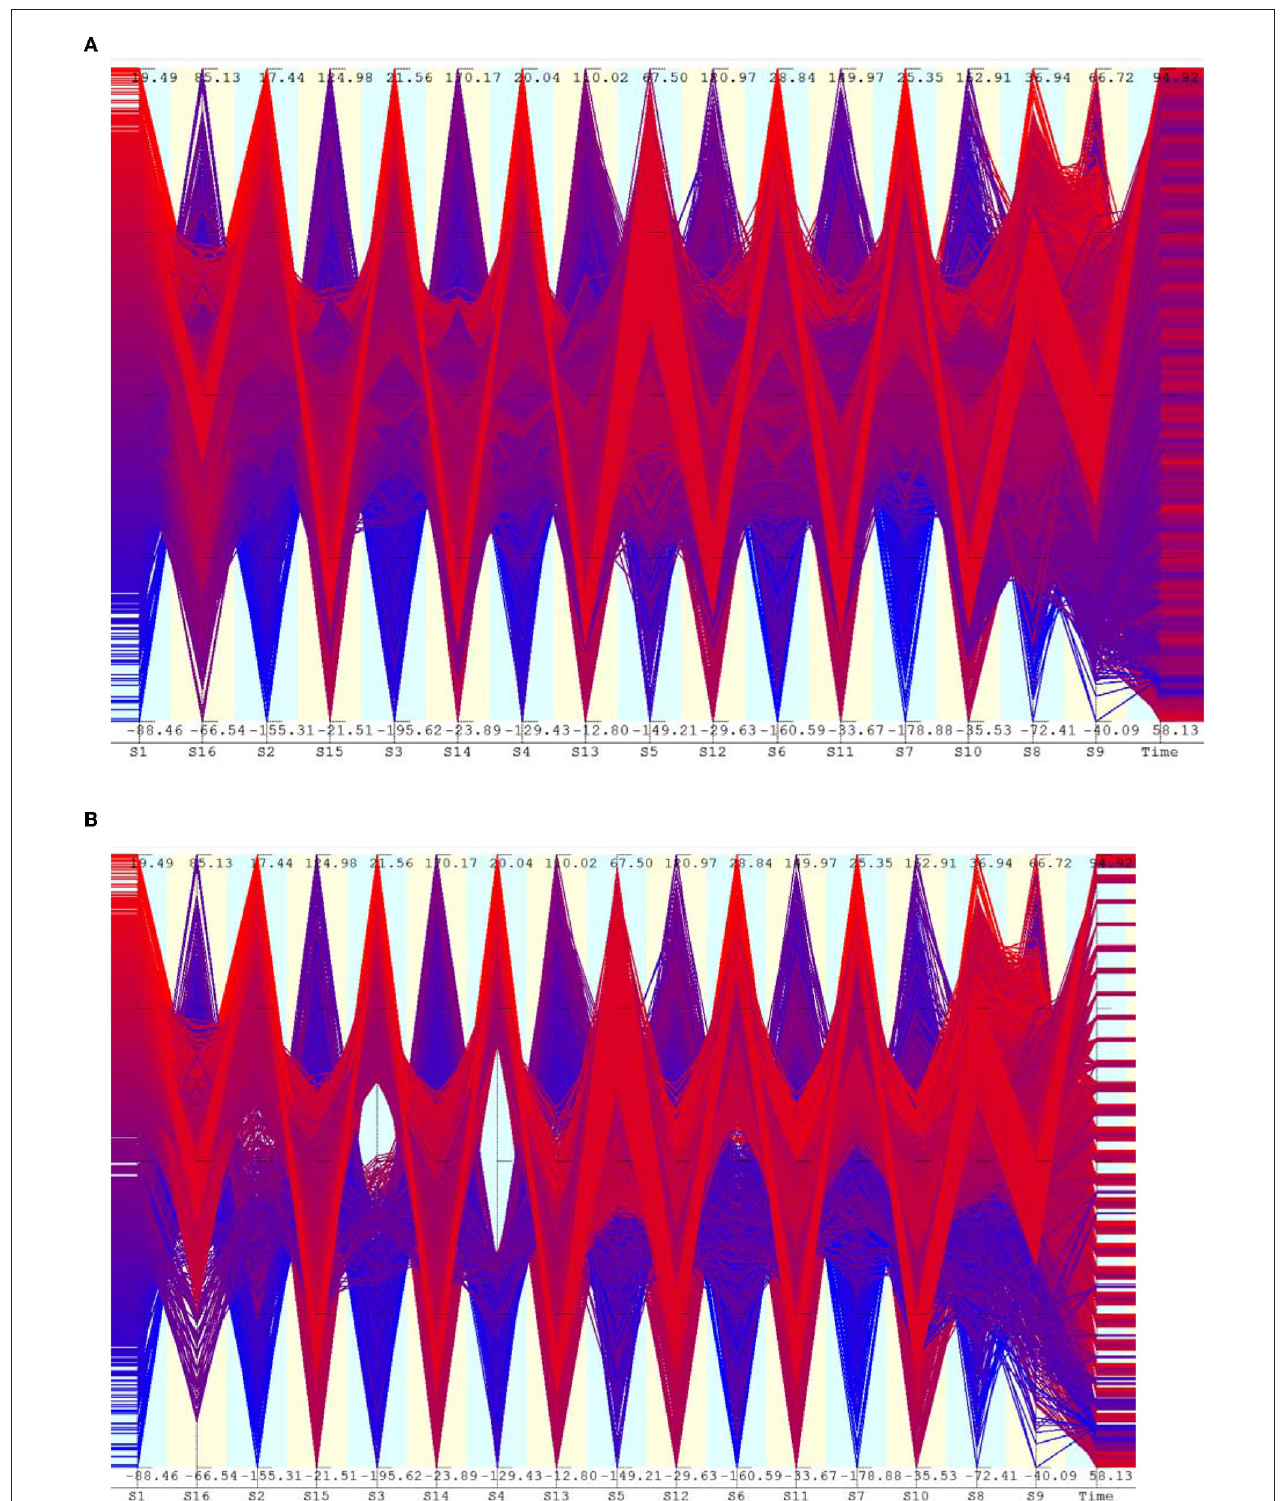
FIGURE 6 | Parallel axis plot of strain data when the train is on the span. (A) Strain at around recording time 58.1s, when the front of the train is at the edge of the girder. (B) Selected data points having high and low values of sensor S4.